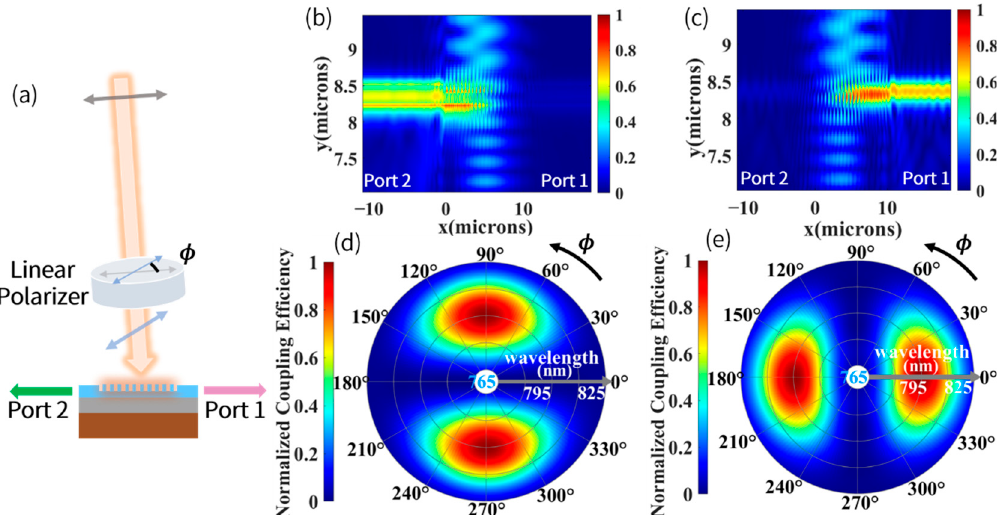
Figure 5. ( a ) Sketch of setup of the grating coupler for testing function of measuring linearly polarized angle φ . ( b ) Electric field distribution along the grating structure when incident light was x-polarized. ( c ) When incident light was y-polarized. ( d ) Simulated normalized coupling efficiency as a function of polarizer rotation angle φ and wavelength of the incident light in Port 1. ( e ) In Port 2.